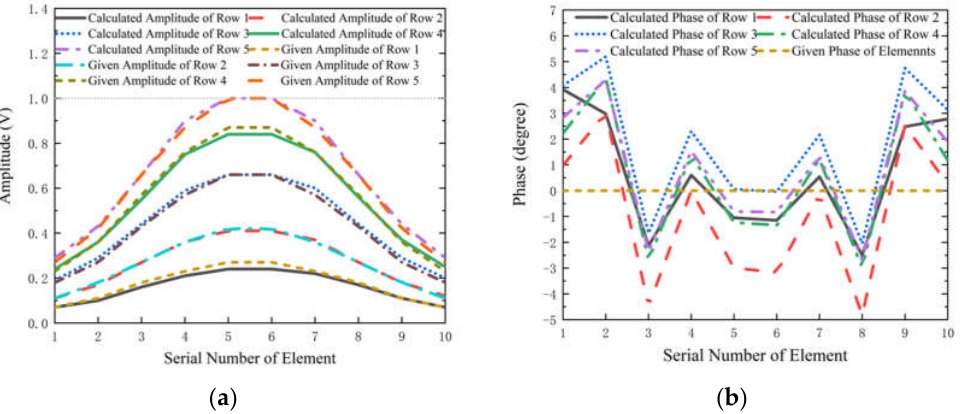
Figure 6. Calculation results of element excitation amplitude and phase. ( a ) Calculated feed ampli- tude as compared to given amplitude and ( b ) calculated feed phase as compared to the given phase.